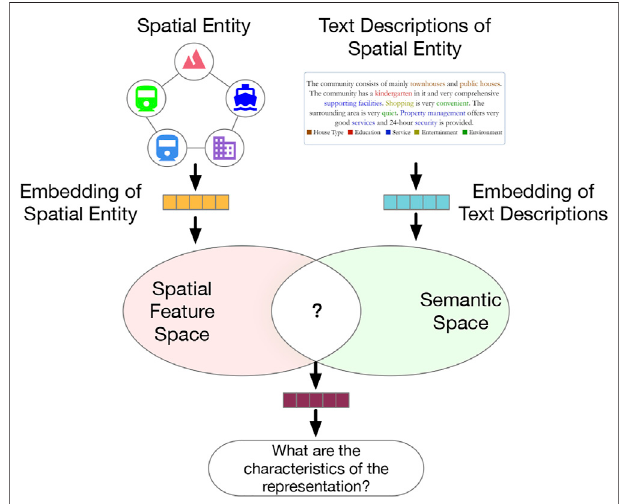
FIGURE1| Themotivationofthefeature-topicpairingproblem:bridging the gap between feature embedding space and topic semantic space in representation